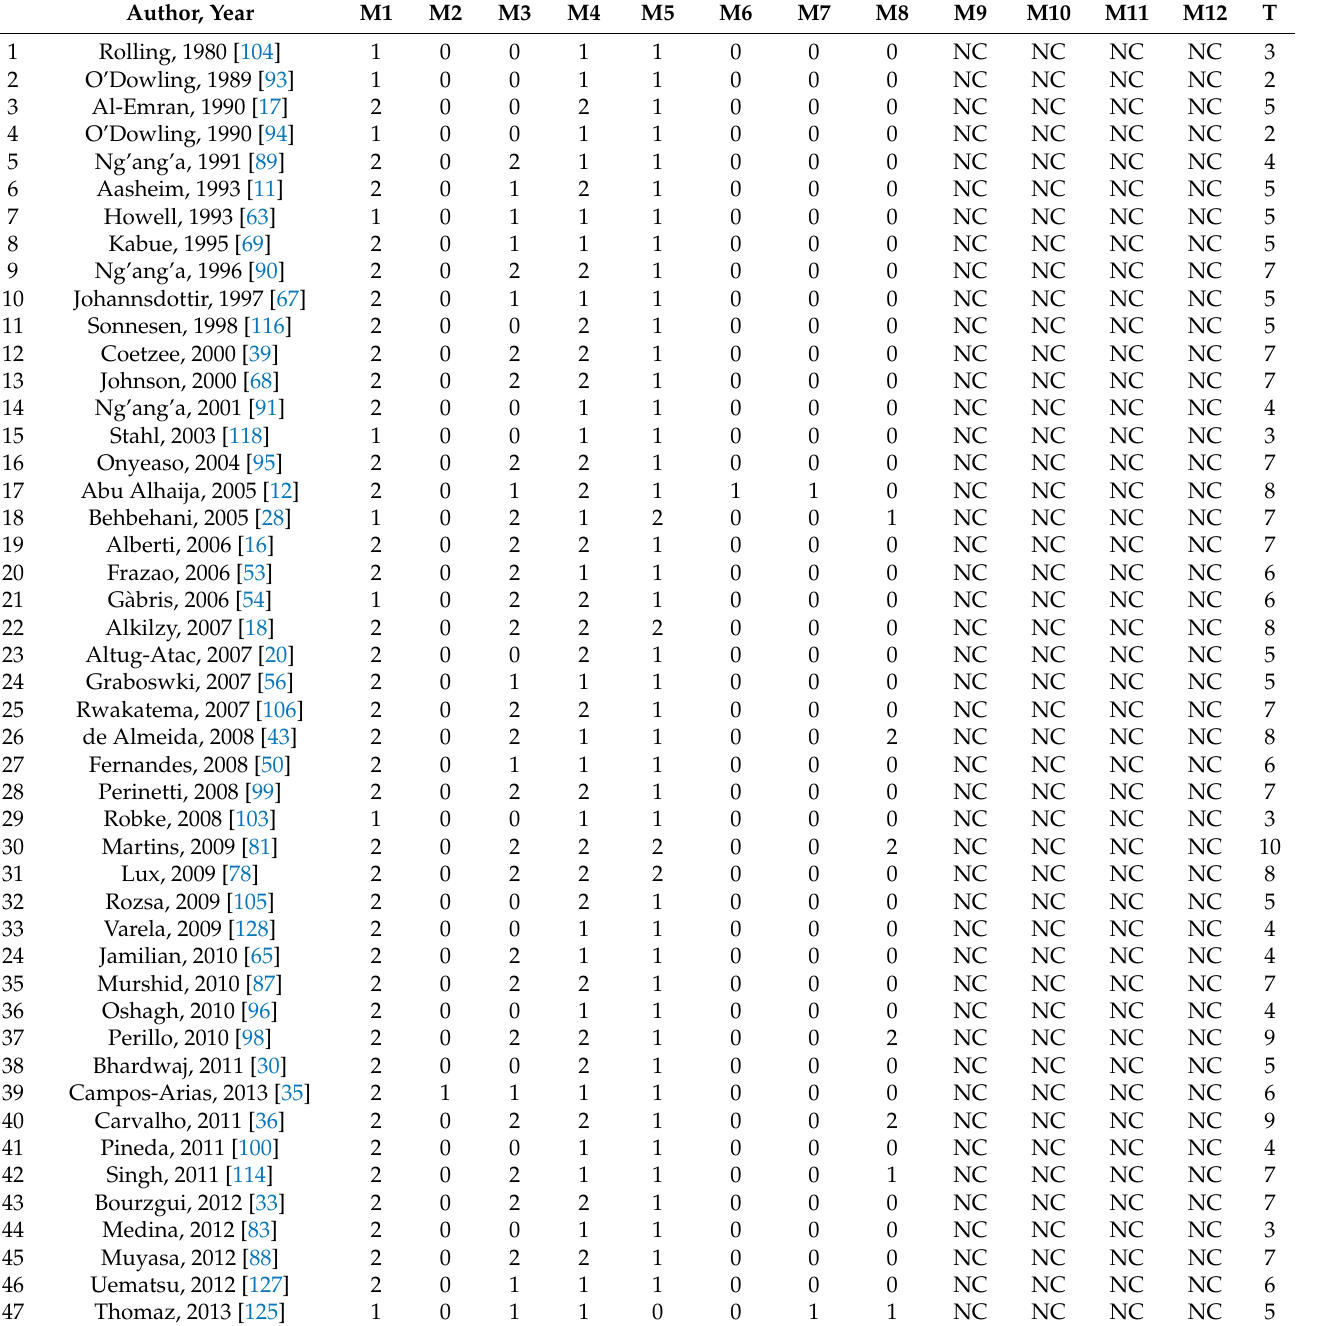
Table 8. Risk of bias assessment according to the MINORS